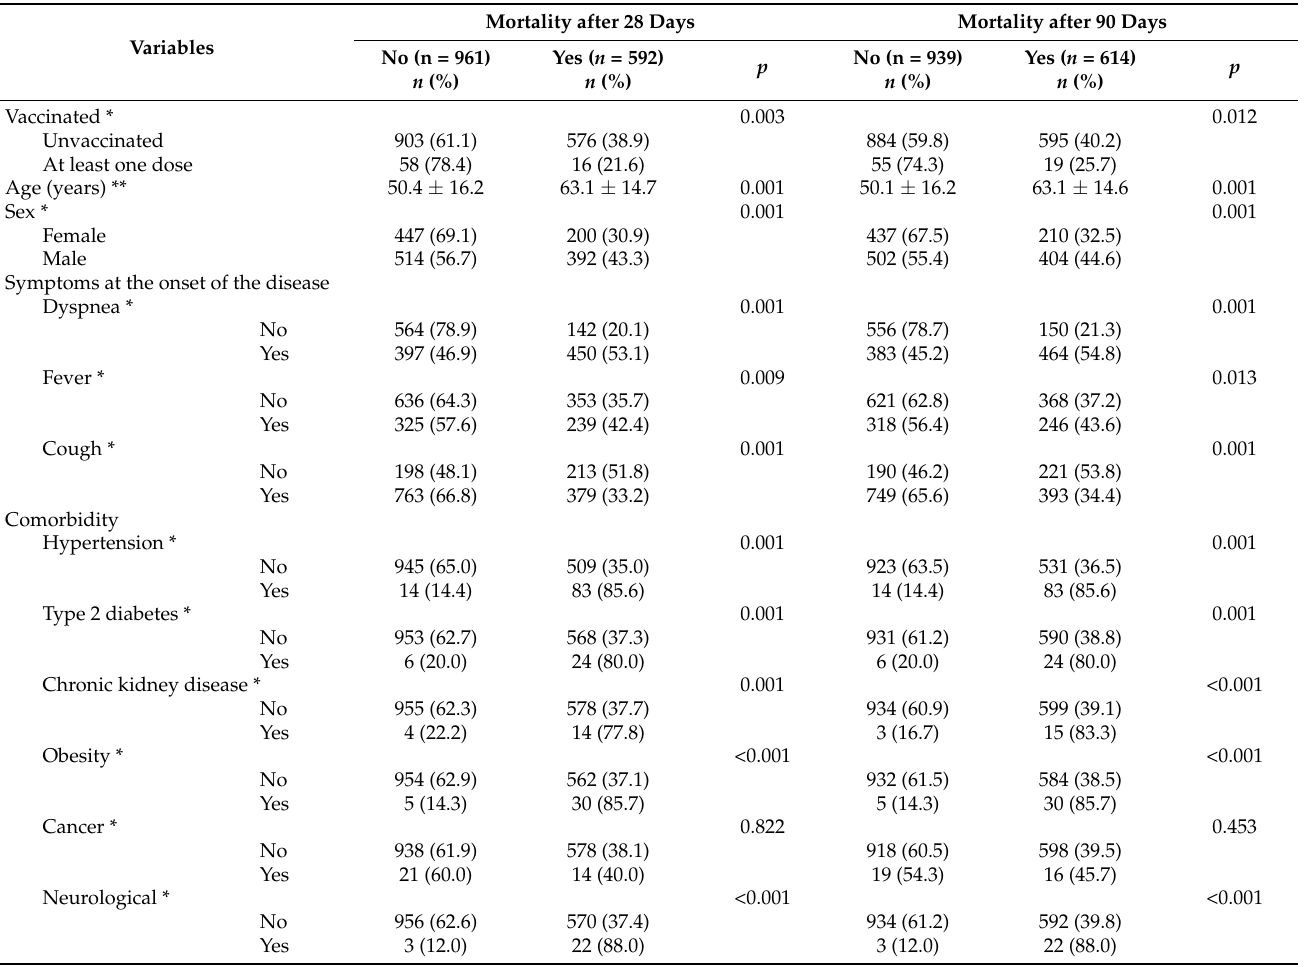
Table 2. Association between vaccination against COVID-19 and mortality in bivariate